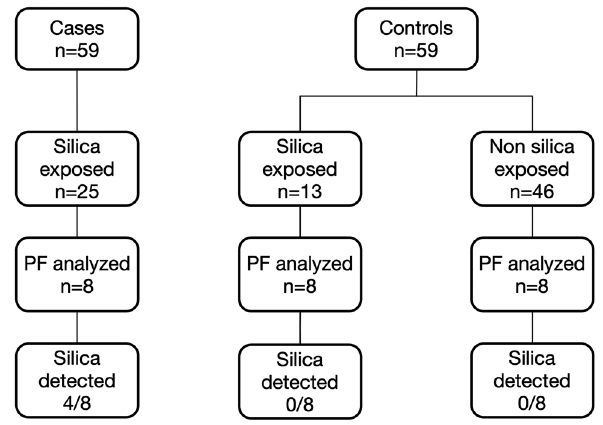
Figure 1: Diagram of selected patients for the analysis of the presence of pleural fluid silica.